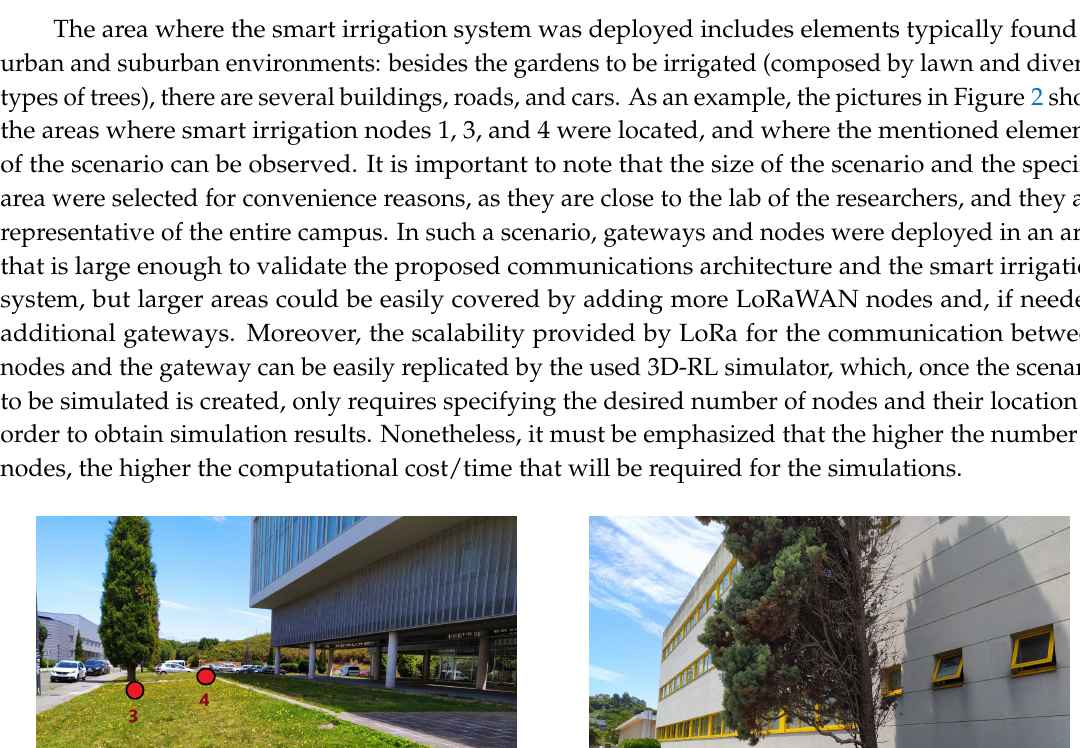
Figure 1. Analyzed scenario with deployed nodes (red circles) and gateway locations (purple circles) (Map source: ©2020 Google).